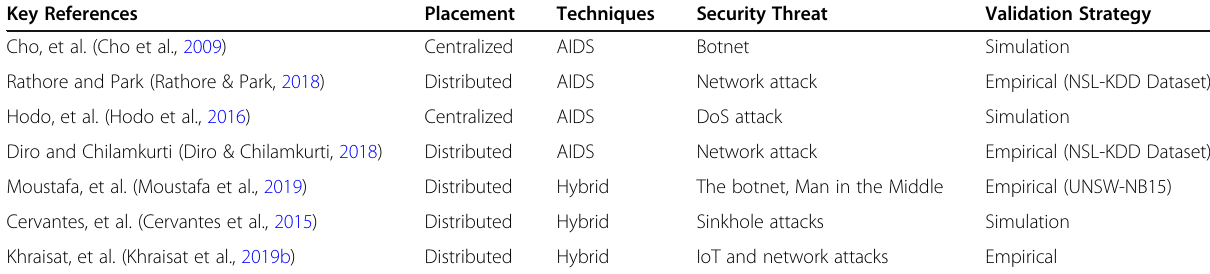
Table 8 Summary of the proposed research to IDSs for